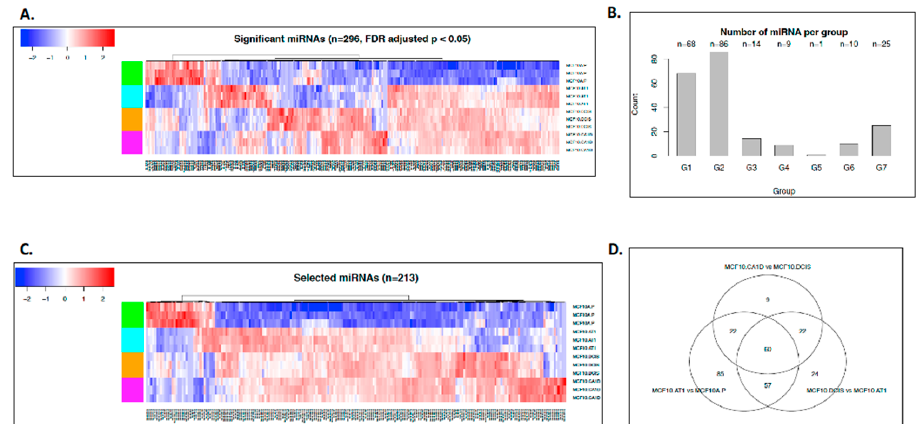
Figure 2. miRNAs that changed significantly during breast cancer progression. ( A ) Heat map showing the expression pattern of all miRNAs (n = 296) that significantly changed across the spectrum of breast cancer progression comprising normal-like (MCF10A.P), preneoplastic (MCF10.AT1), DCIS (MCF10.DCIS), and invasive cancer (MCF10.CA1D) cells. The color key shows blue as the lowest expression and red as the highest expression. ( B ) Bar diagram showing the number of miRNAs that mapped to the predefined groups of interest. ( C ) Heat map showing the expression pattern of 213 miRNAs that mapped to one of the eight predefined groups of interest, which depicts global miRNA changes during breast cancer progression. ( D ) Venn diagram showing the number of miRNA changes that were distinct or shared among normal to preneoplastic (MCF10A.P to MCF10.AT1), preneoplastic to DCIS (MCF10.AT1 to MCF10.DCIS), and DCIS to invasive cancer (MCF10.DCIS to MCF10.CA1D).